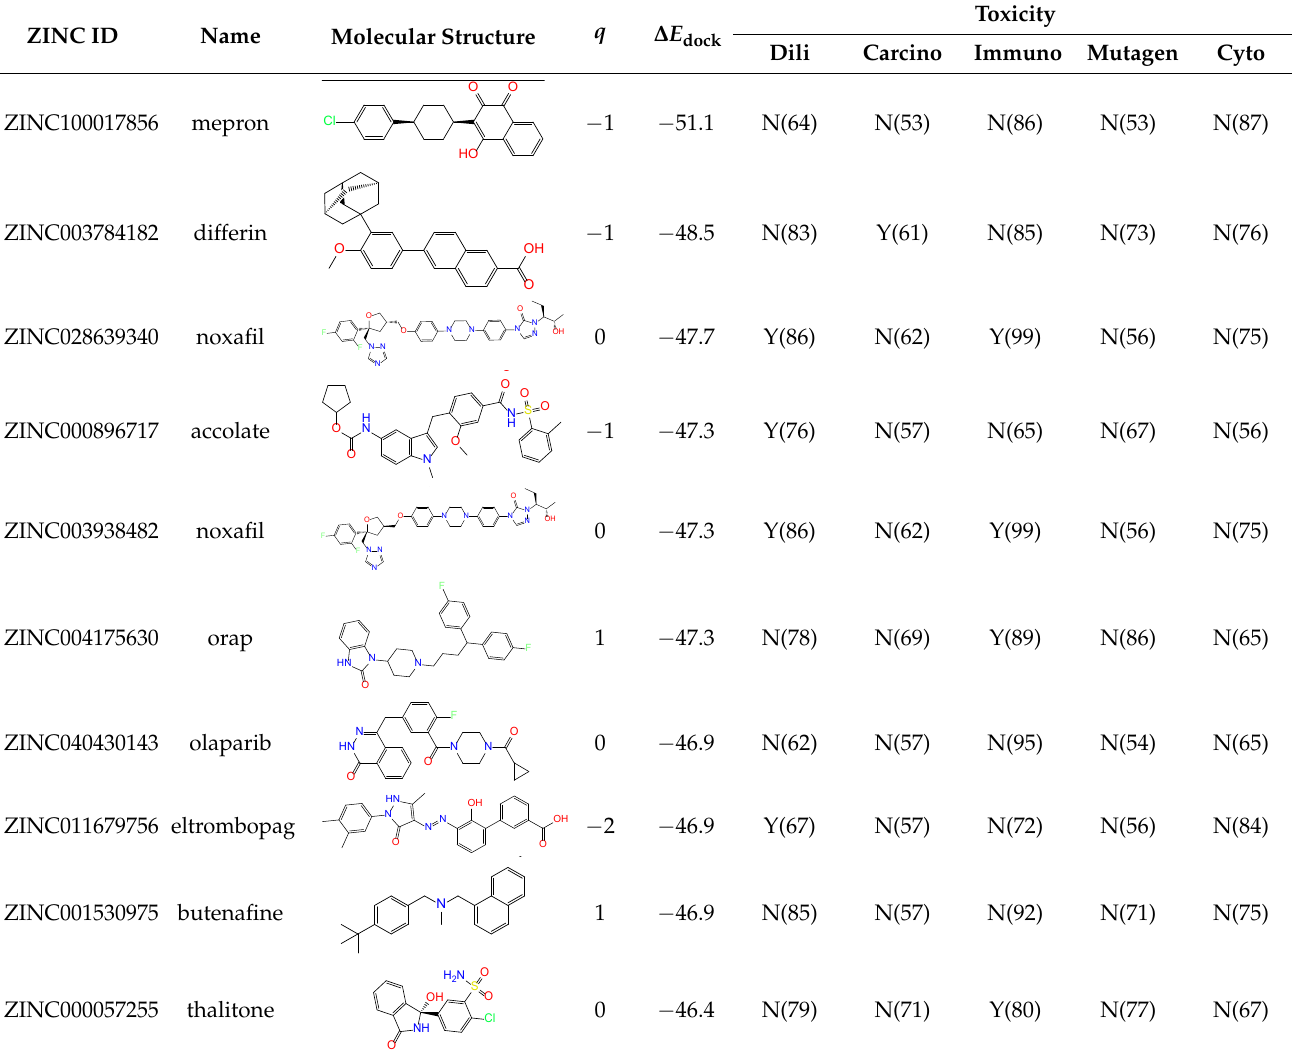
Table 2. Top 10 compounds from virtual screening of FDA-approved drugs via Autodock Vina using MD-derived structures of ALDH2 as receptor and the toxicity prediction via ProTox-II.